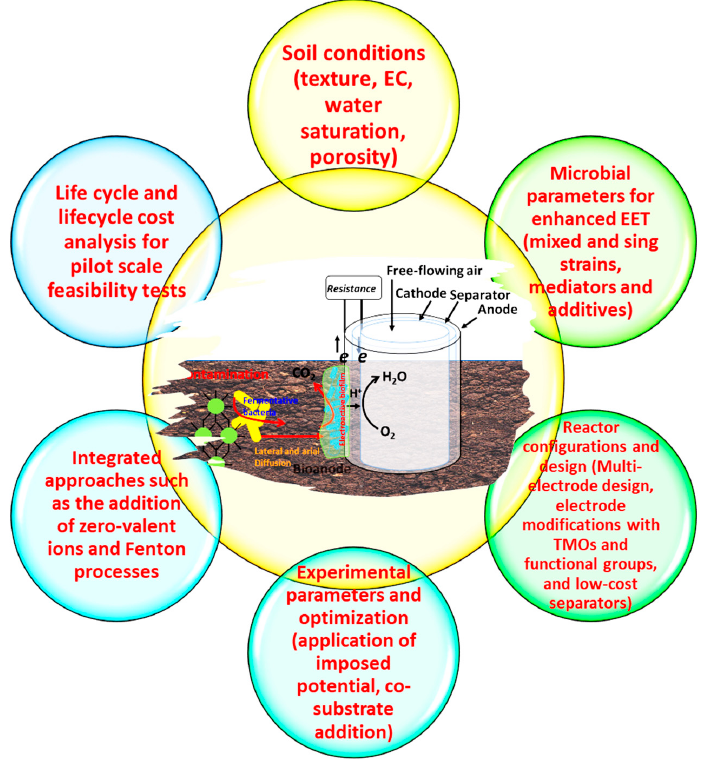
Figure 6. An integrative approach and future research directions for improving BES performance. The rate of the reaction at the electrode can be improved by distinctive approaches, for example, by adding conducive nanoparticles to enhance the electron transport process between microbe-microbe and microbe–electrodes, improving anode electrode features, increasing the availability of supplements for the microbes, and enriching microbial di- versity in the soil [123]. The utilization of microbes capable of conducting long-distance electron transfer using conductive materials as electron conduits can help improve the reaction rate [145,146]. Although soil amendments with waste-biomass-derived carbon materials (e.g., biochar and activated carbon) showed improved microbial interactions, their electrochemical activity can be enhanced further by surface medications with hydro- philic functional groups and altering surface zeta potential. Further research efforts are needed to amend the soil with bioactive additives; for example, the application of leaf extracts with enriched bioactive compounds such as epigallocatechin-3-gallate (EGCG) , gal- locatechin , gallic acid , and anthocyanin could be a cost-efficient option to enrich the soil for enhanced microbial metabolism [147–150]. Excellent electrode materials with good stabil- ity and catalytic properties are required to be developed; biochar and activated-carbon- modified anode electrodes have shown promising results due to their high activated sur- face area, but their low electrical conductivity can hamper reaction kinetics at the anode [32]. Therefore, transition-metal (Fe, Co, and Mn)-doped biochar or activated carbon can address low electrical conductivity issues and can also significantly improve bioelectro- chemical activity [151]. Moreover, electrodes modified with a hydrophilic functional group such as -NH 2 , -COOH, -OH, etc., showed enhanced attachment with microbes via weak hydrogen bonding and electrostatic attraction, which promoted early-stage biofilm development in BES [44,127]. Moreover, anodes modified with conductive polymers, such as polyaniline, polypyrrole, polymer dots, and low-cost transition metal oxides, have also shown enhanced activity toward microbial attachment and improvement in BES